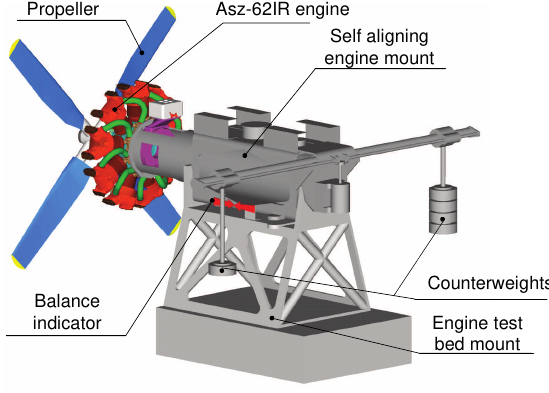
Fig. 2. Schematic of the engine section at the engine test